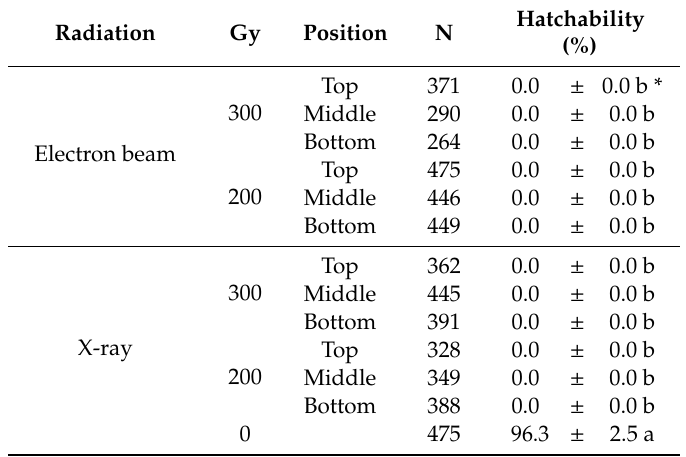
Table 6. Mean ( ± SD) egg hatchability (%) of T. vaporariorum at three di ff erent locations (top, middle, and bottom) in boxes filled with strawberry fruits irradiated by 200, 300 Gy of electron beam and X-rays. Hatchability Radiation Gy Position N